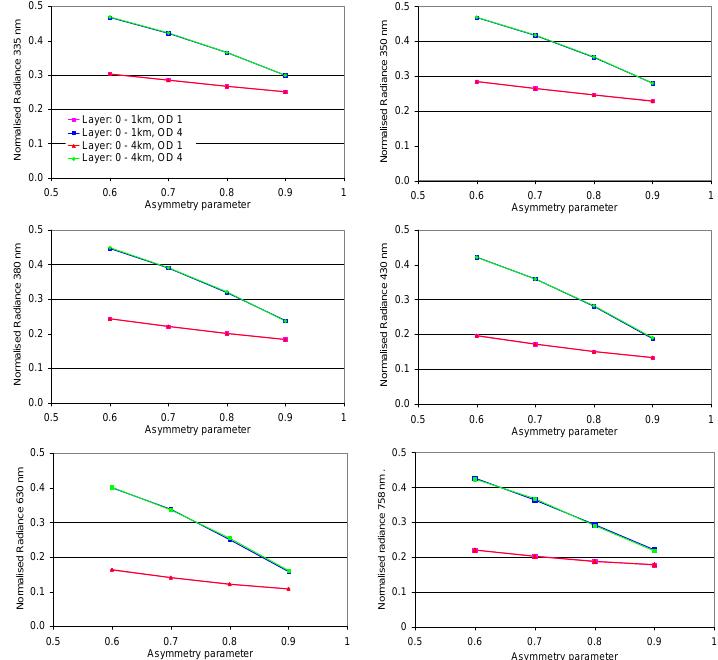
Fig. A8 Dependence of the normalised radiance on the aerosol asymmetry parameter g. The calculations are performed for aerosol single scattering albedo of 1, SZA of 30°, and a Fig. A8. Dependence of the normalised radiance on the aerosol asymmetry parameter g . The calculations are performed for aerosol single viewing angle of -90° (nadir geometry). For 758 nm the surface albedo was set to 20%, for scattering albedo of 1, SZA of 30 ◦ , and a viewing angle of − 90 ◦ (nadir geometry). For 758nm the surface albedo was set to 20%, for 630nm 630 nm to 10%, and for all other wavelengths to 5%. to 10%, and for all other wavelengths to